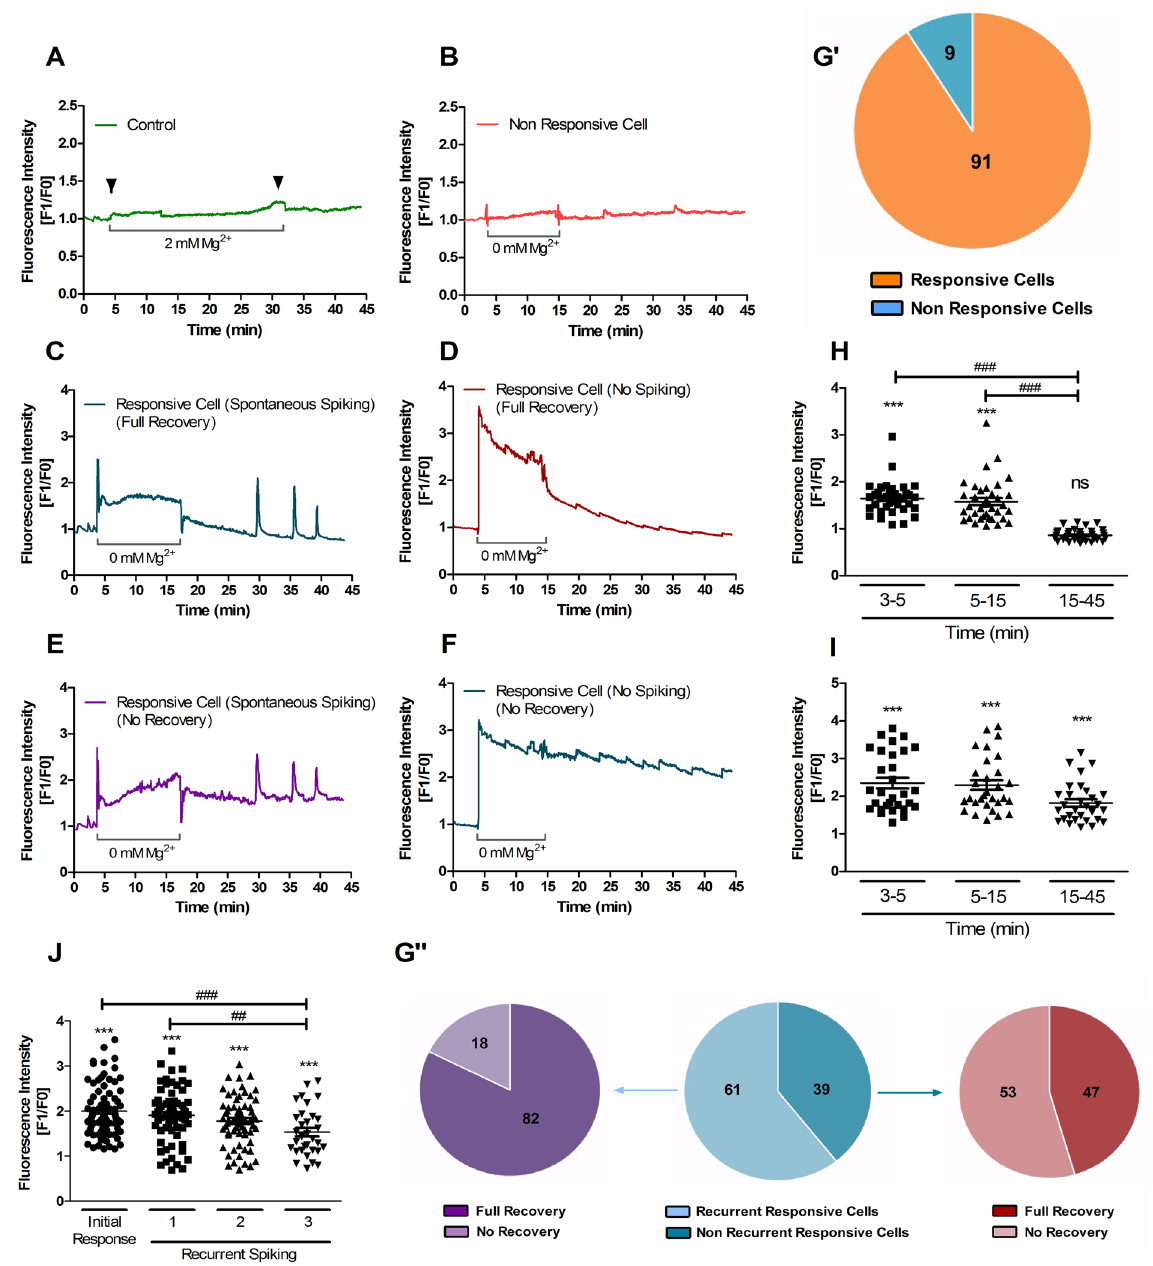
Figure 4. Characterization of [Ca 2+ ] i transients induced by incubation of hippocampal neurons in [Mg 2+ ] 0 medium for 15 min. ( A–F) Cultured hippocampal neurons (15 DIV) were analysed by single cell calcium imaging using the fluorescent Ca 2+ indicator Fluo-4, with Spinning Disk microscopy. The cells were initially incubated in control salt solution containing 2 mM Mg 2+ for 3 min to determine the baseline fluorescence level. After 3 min, the solution was replaced with [Mg 2+ ] 0 medium for the indicated period of time. At t = 15 min the buffer was replaced by control salt solution for an additional period of 30 min. In the experiment described in panel A , where indicated by the arrows the Mg 2+ -containing salt solution was changed to a buffer with the same composition. Fluo-4 fluorescence was recorded for the duration of the experiment. For each time point the results are represented as the normalized intensity of Fluo-4 fluorescence (fluorescence for a given time point divided by the baseline fluorescence). The analyses represent the different types of response to the [Mg 2+ ] 0 medium. ( G ′ -G ″ ) Pie chart representation of the types of response to [Mg 2+ ] 0 medium in percentage of total cells with the indicated pattern of response. ( H, I ) A comparative analysis of the [Ca 2+ ] i response profile was made between cells that were able to recover to basal calcium levels, ( C and D ; H ) and the cells that did not ( E and F ; I ). ( J ) [Ca 2+ ] i transients were comparatively analysed to determine the differences between the initial response to the incubation in [Mg 2+ ] 0 medium and the spontaneous oscillations that developed after the stimulus (in Sham medium). Results are the mean ± SEM of at least three independent experiments performed in distinct preparations, *** p < 0.001, ## p < 0.01, ### p < 0.001; Repeated measures ANOVA followed by Dunnett’s (*) and/or Bonferroni test ( # ). ns, not significantly